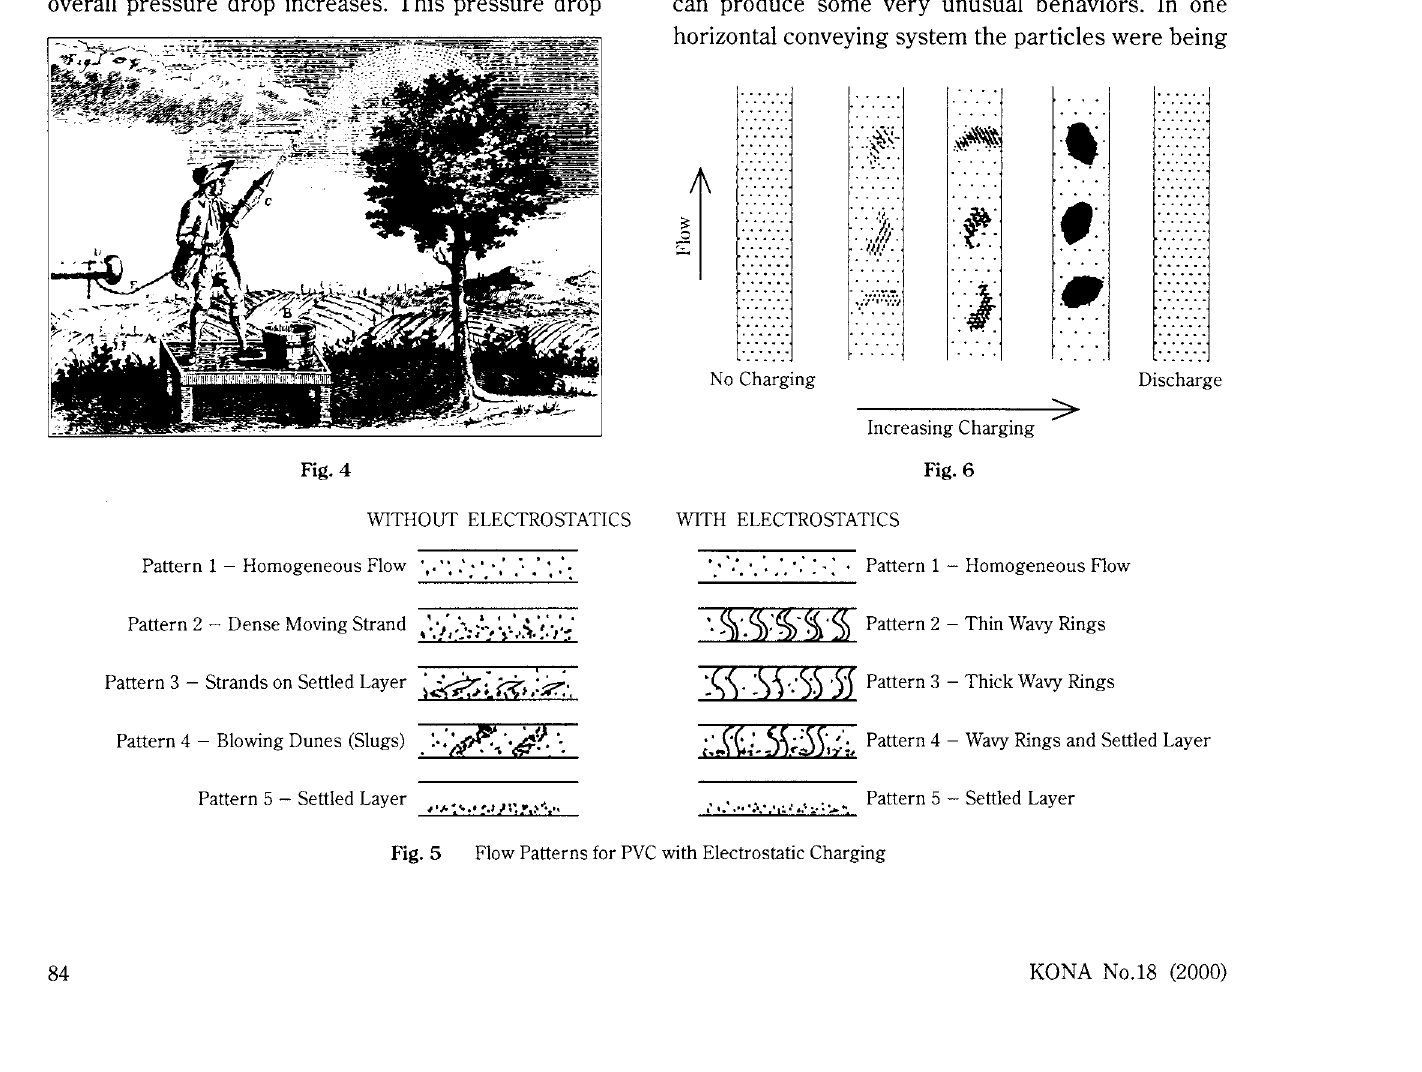
Fig. 5 Flow Patterns for PVC with Electrostatic